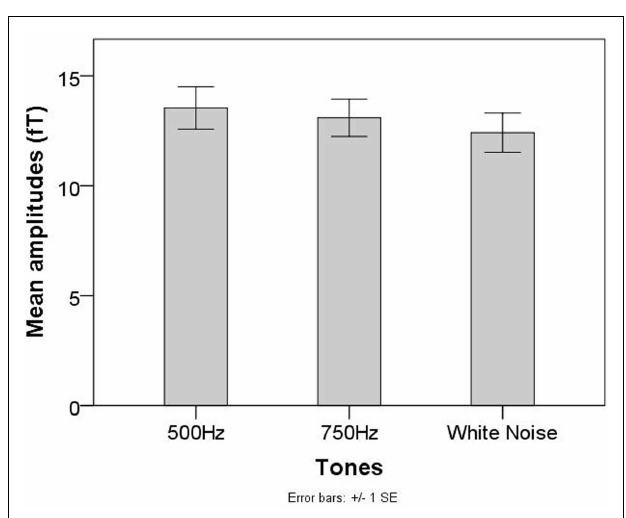
FIGURE 3 | MeanAER amplitudes for the 500Hz, 750Hz, andWN stimuli in the group of neonates/infants of theTuebingen study .